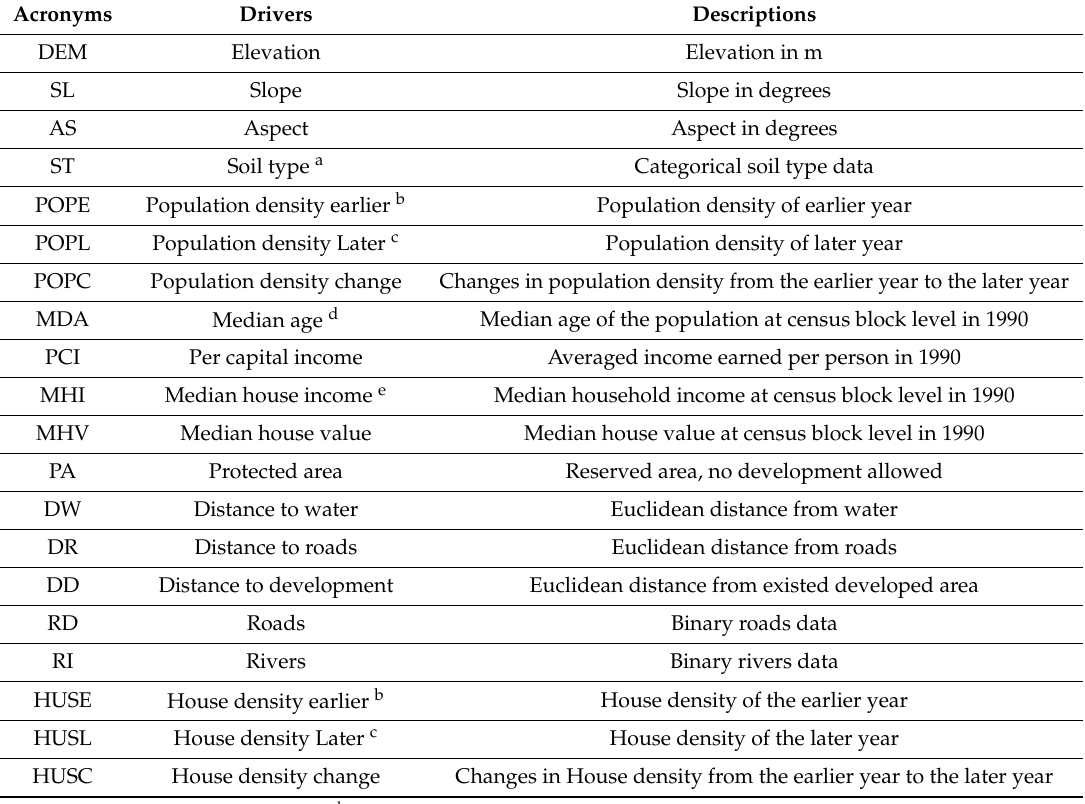
Table 2. Acronyms, names, and descriptions of the driving forces used in this